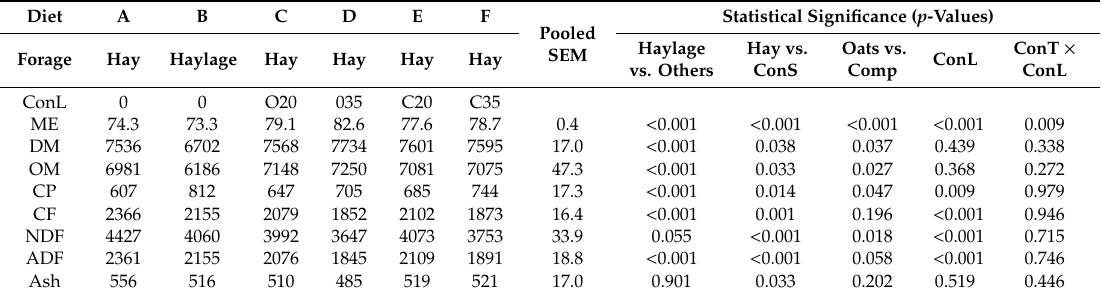
Table 2. Mean daily energy (MJ ME), dry matter (g) and nutrient intakes (g) for the experimental diets. Diet A B